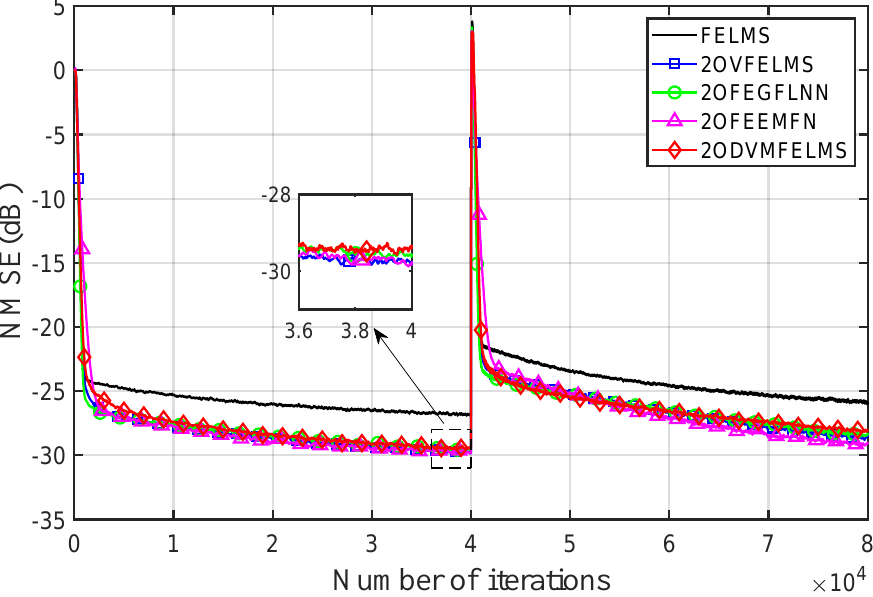
Figure 9. Performance comparison using measured primary and secondary path with saturated reference